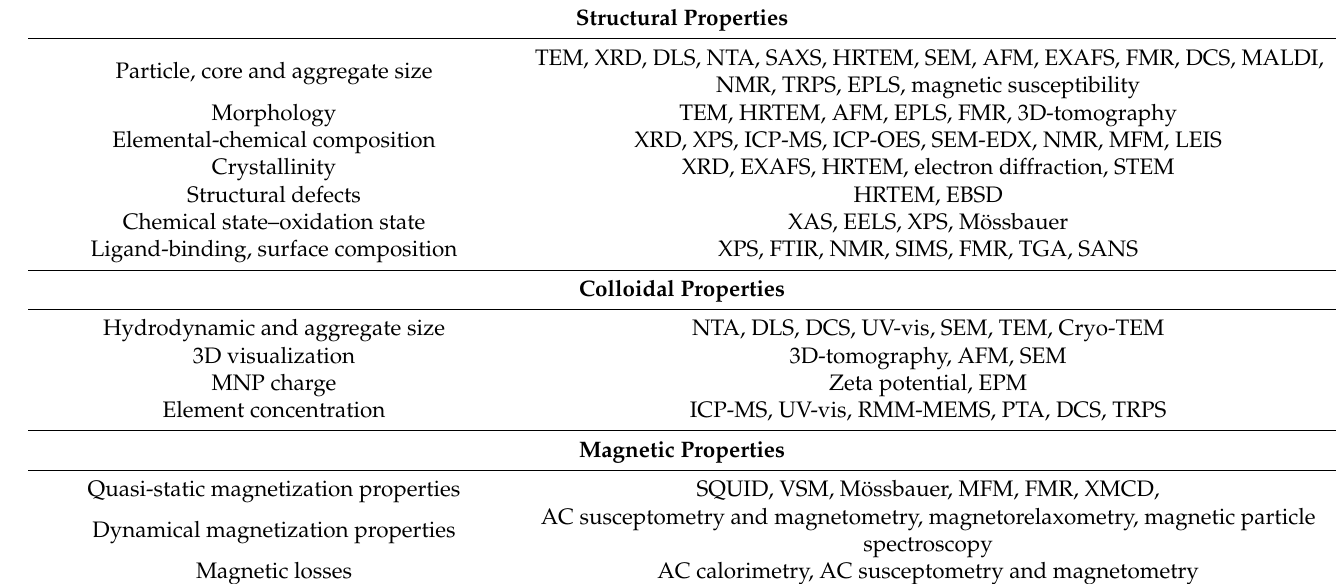
Table 1. MNP parameters and the corresponding characterization techniques. Adapted from [15,16]. See list of acronyms at the end of the